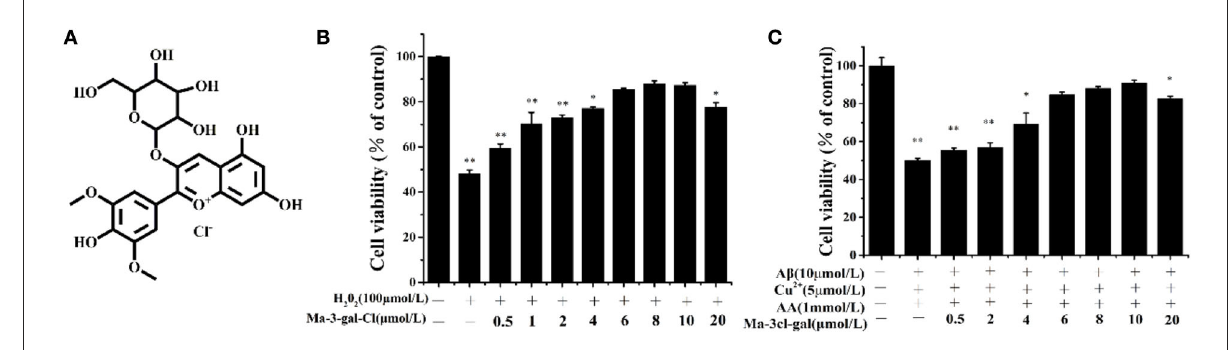
FIGURE2 Molecular structure of Ma-3-gal-Cl (A) , and cell viability of SH-SY5Y cells treated with different solutions (B,C) . * p < 0.05 and ** p < 0.01 compared to control values.